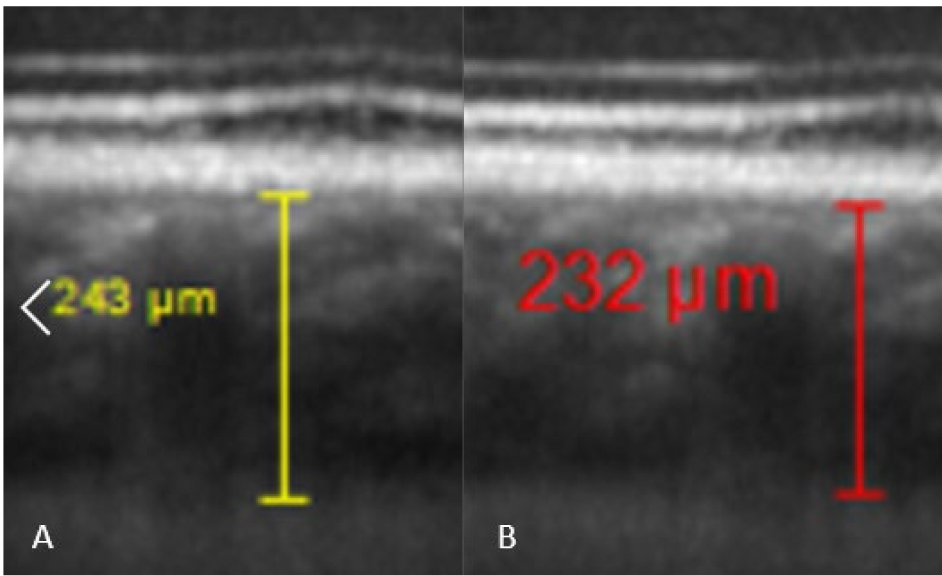
Figure 4. Comparison of SFCT in the same diver before the dive (( A ), SFCT estimated at 243 µ m by one of the investigators), and 30 min after the dive (( B ), SFCT estimated at 232 µ